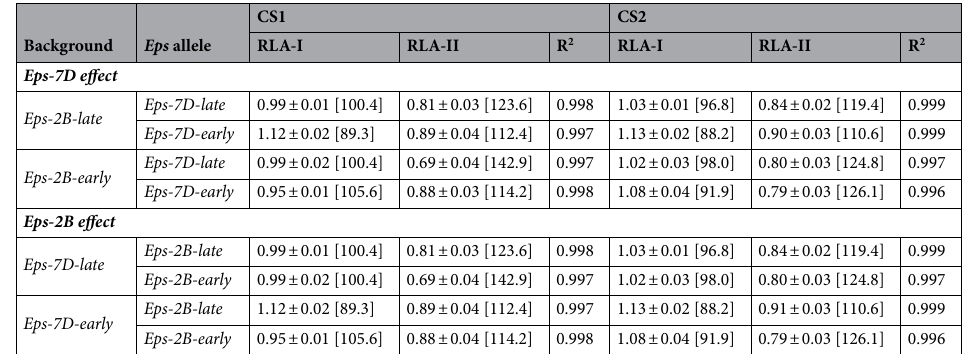
Table 4. Rates of leaf appearance (leaves [100 °C day] −1 ; ± SE) corresponding to the early- and late-appearing leaves (RLA-I and RLA-II, respectively) as affected by Eps-7D and Eps-2B genes (top and bottom parts of the table, respectively) on backgrounds contrasting in the allelic form of the other Eps gene in the two cropping seasons (CS1 and CS2), and coefficients of determination of the segmented linear regression (in all cases P < 0.001). The corresponding phyllochron values (ºC d leaf -1 ) are included between square brackets.